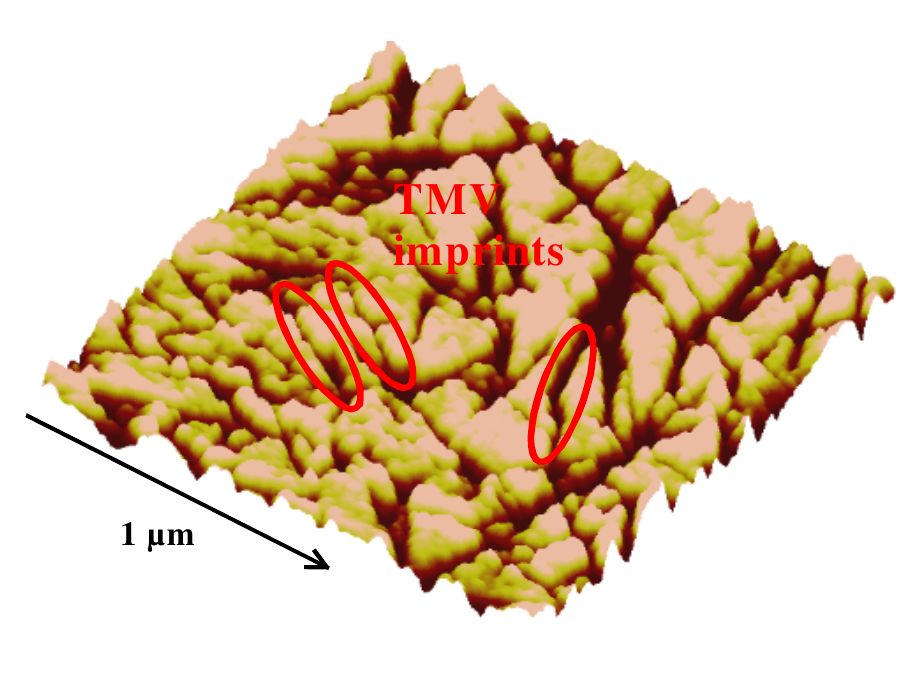
Figure 9: TMV-imprinted polyurethane